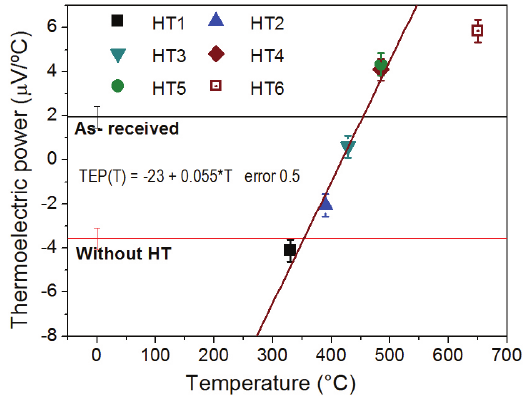
Figure 6. TEP vs. temperature of heat treatment.